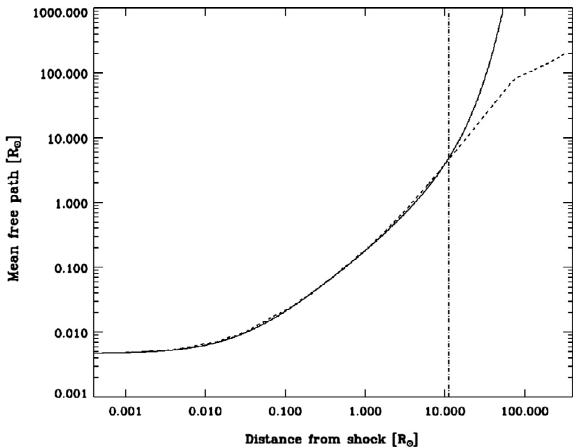
Fig. 7. The modelled mean free path. The dashed curve gives the CSA-simulated mean free path of 2.84-MeV protons and the solid curve the result from the semi-analytical model. The vertical dot- dashed line gives the position of the foreshock boundary. The considered case is Run 2c.